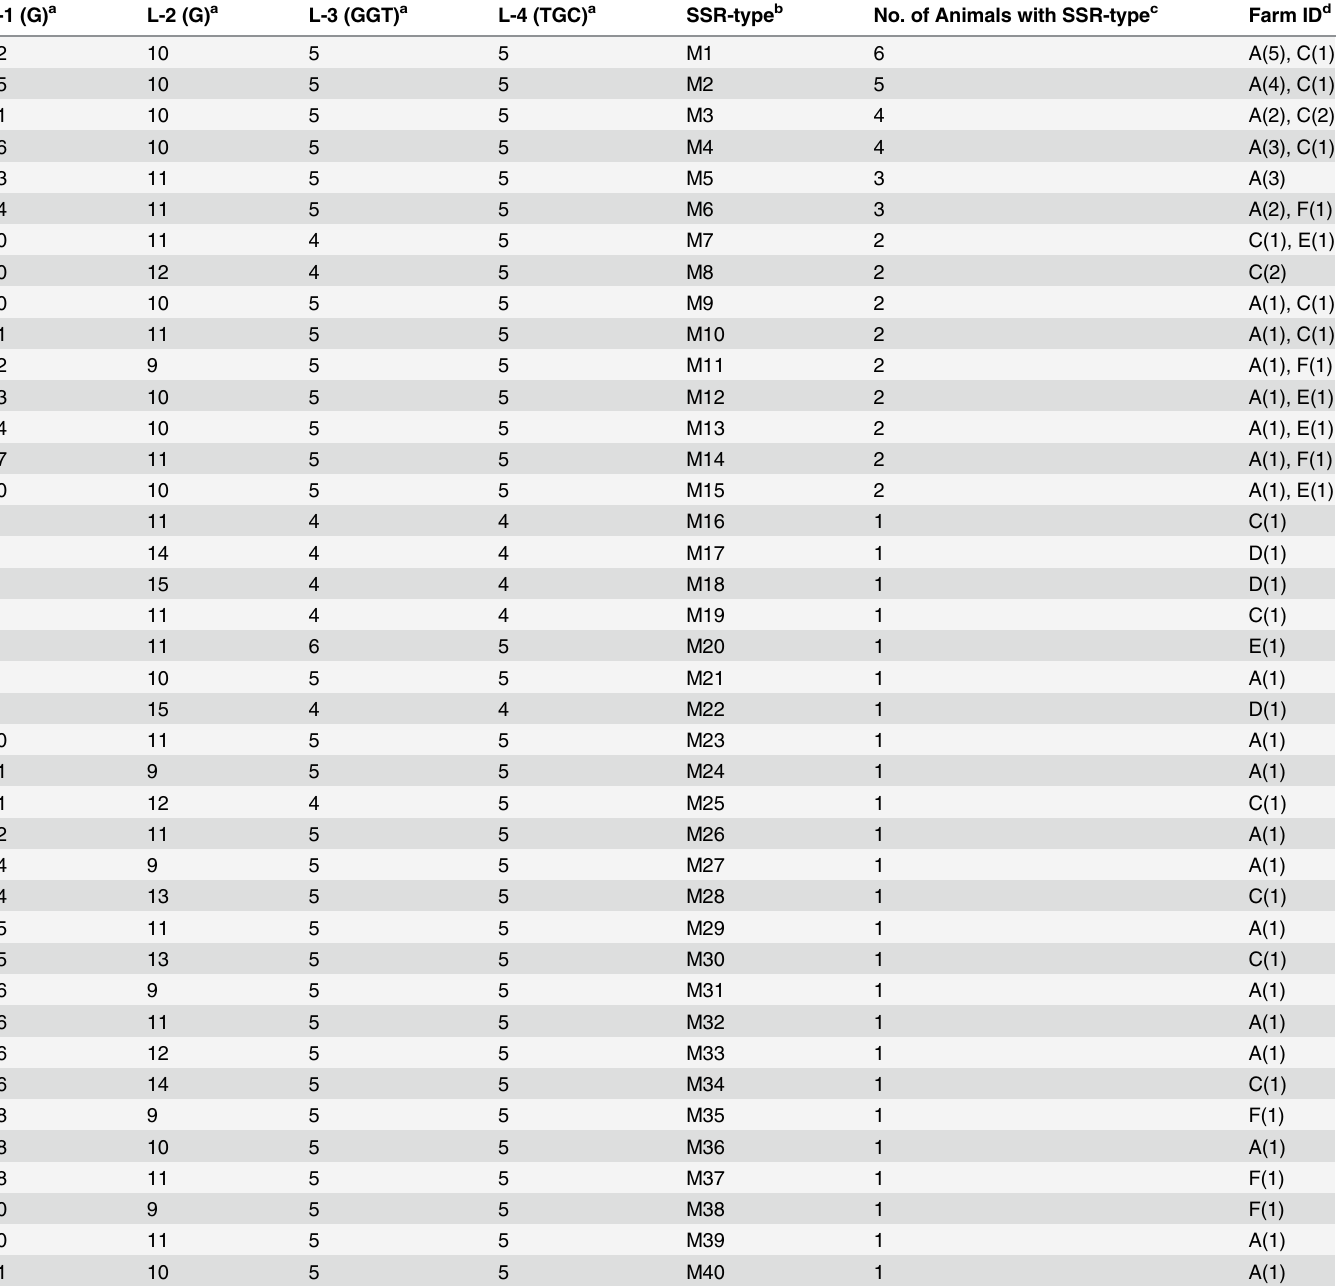
Table 1. Details of the 40 SSR-types that were identified using fragment analysis from Map isolated from five Newfoundland dairy farms in the cur- rent study. L-1 (G)